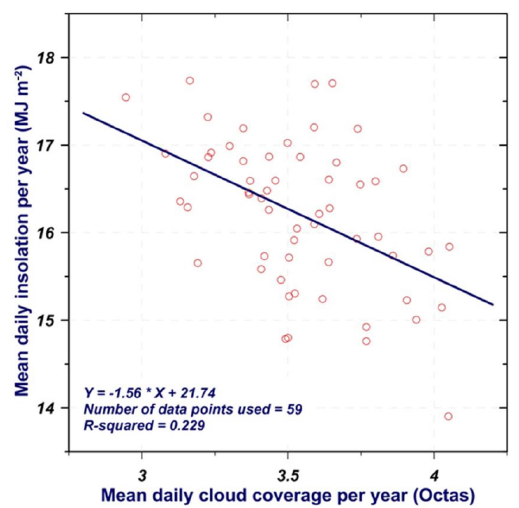
Figure 8. Correlation between annual means of daily insolation and cloud cover over the period 1954–2012. The straight line represents the best-fit regression line to the data points. The year 1953 has not been included in the analysis since it does not include measurements for all